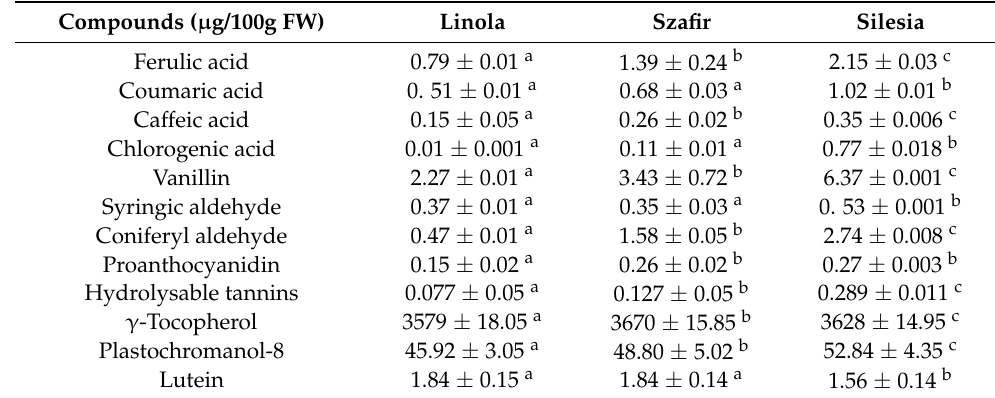
Table 6. The content of antioxidants in oil depending on variety. All results are statistically significant ( p < 0.05). Different superscripts imply significant